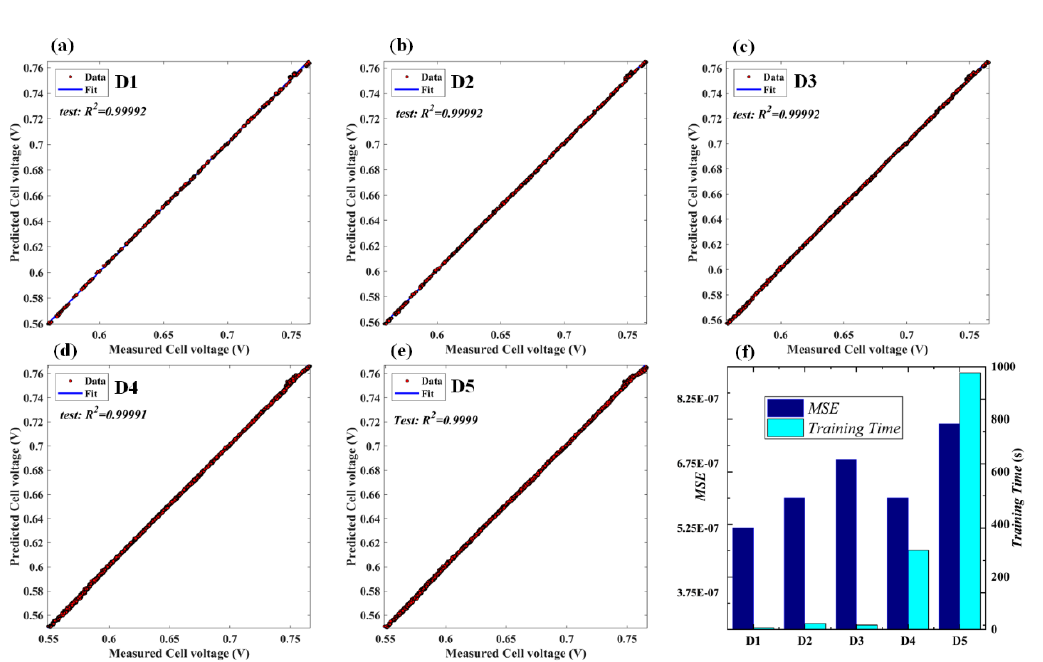
2 for D1 (6-8-5-5); ( b ) R 2